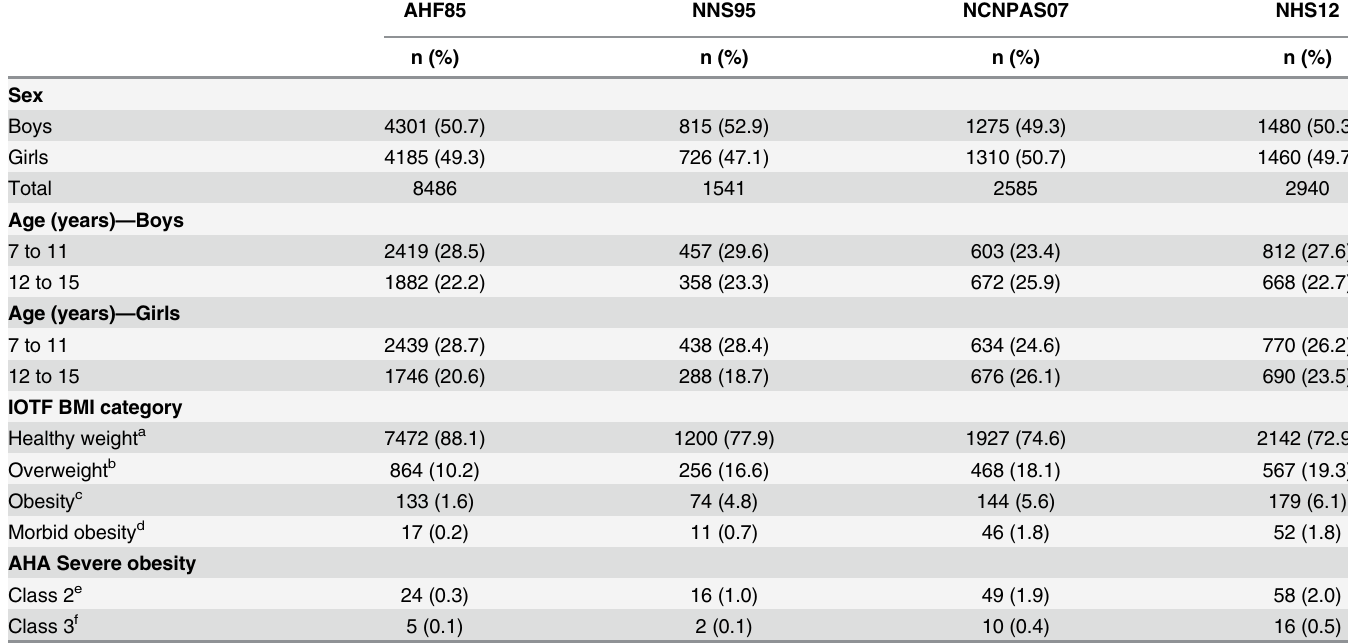
Table 1. Characteristics and BMI status of Australian children age 7 to 15 years 1985, 1995, 2007 and